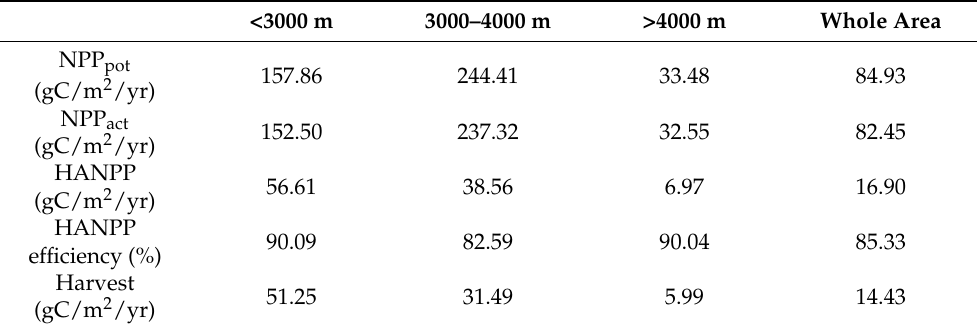
Table 1. NPP pot , NPP act , HANPP, HANPP efficiency, and harvest (consumed by livestock) at different altitudes in Qinghai grasslands in the period of 1979 to